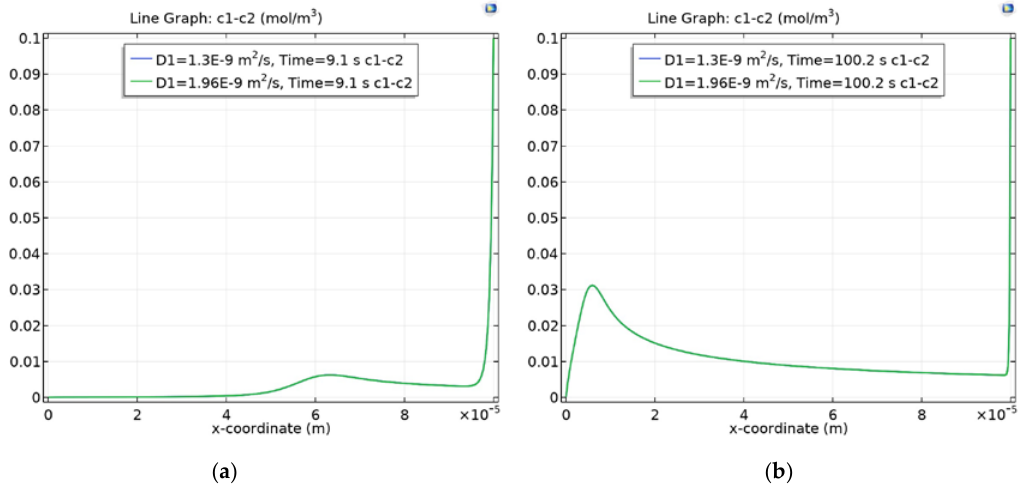
Figure 3. Wave charge when d = 0.1 when t ≈ 9 c ( a ) and t ≈ 100 c ( b ). The blue and green lines (they merge with great accuracy) correspond to solutions of NaCl and KCl.